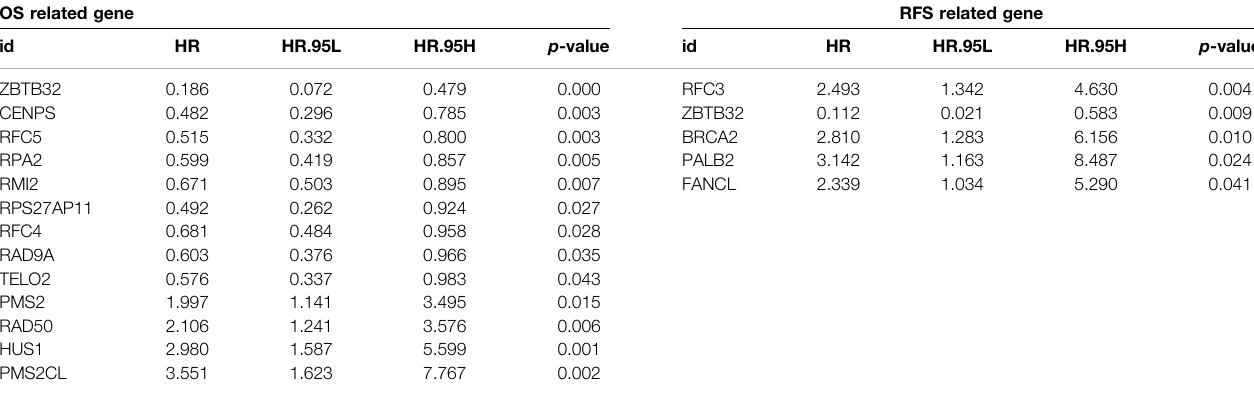
TABLE 3 | Signi fi cant FARGs screened out by univariable cox regression analysis for FPS model fi tting. OS related gene RFS related gene id